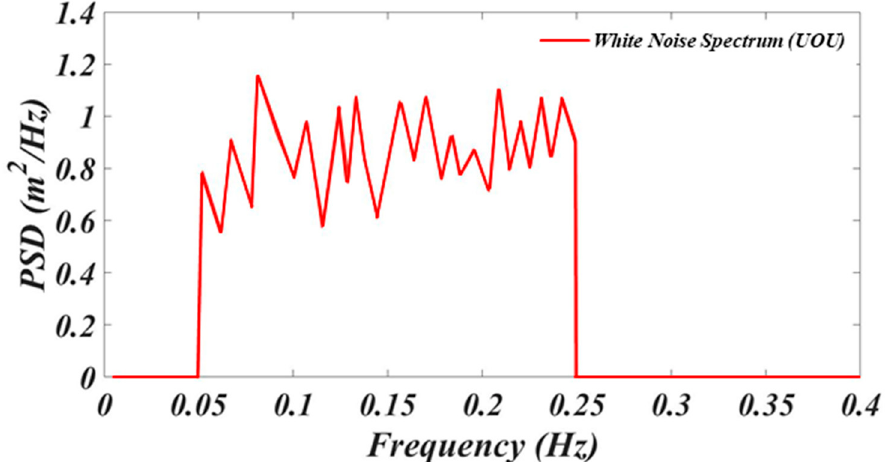
Figure 10. The schematic of the white-noise spectrum.